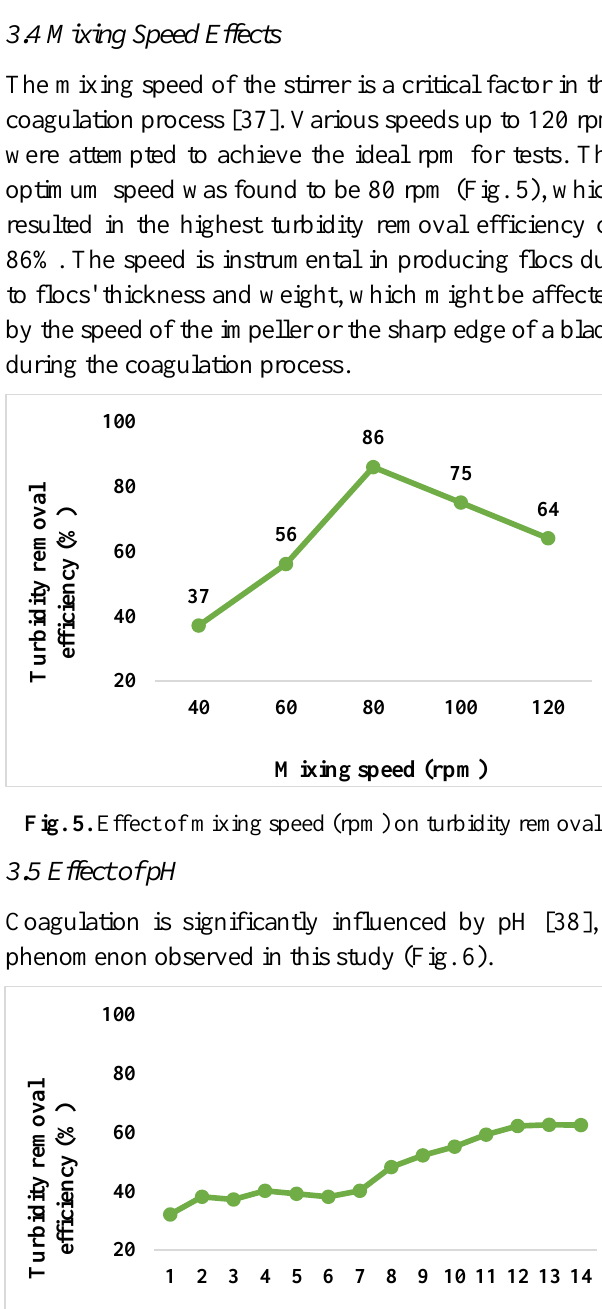
Fig. 4. Effect of powdered neem seed dosage on turbidity removal